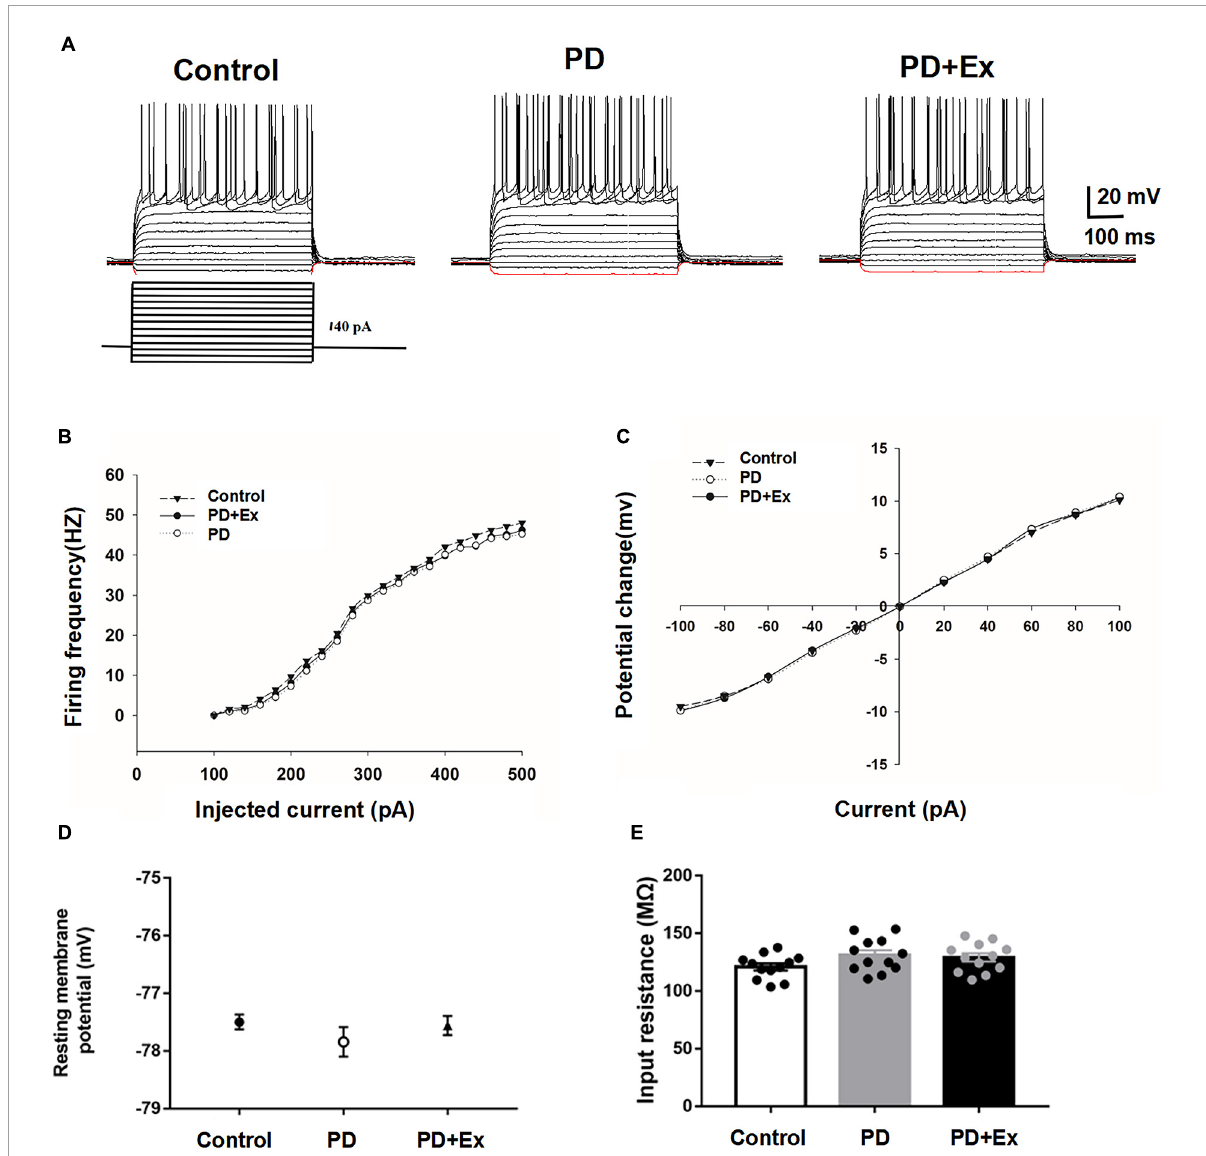
FIGURE4 Basic electrophysiological properties of D2-MSNs in each group. (A) Sample traces obtained from a MSN in response to injection of hyperpolarizing and depolarizing current pulses. The firing rate vs. injected current (B) and I–V curves (C) were indistinguishable among the three groups. Resting membrane potential (D) and input resistance (E) were both comparable among the three groups (one-way ANOVA, p > 0.05). All data are showed as mean ±